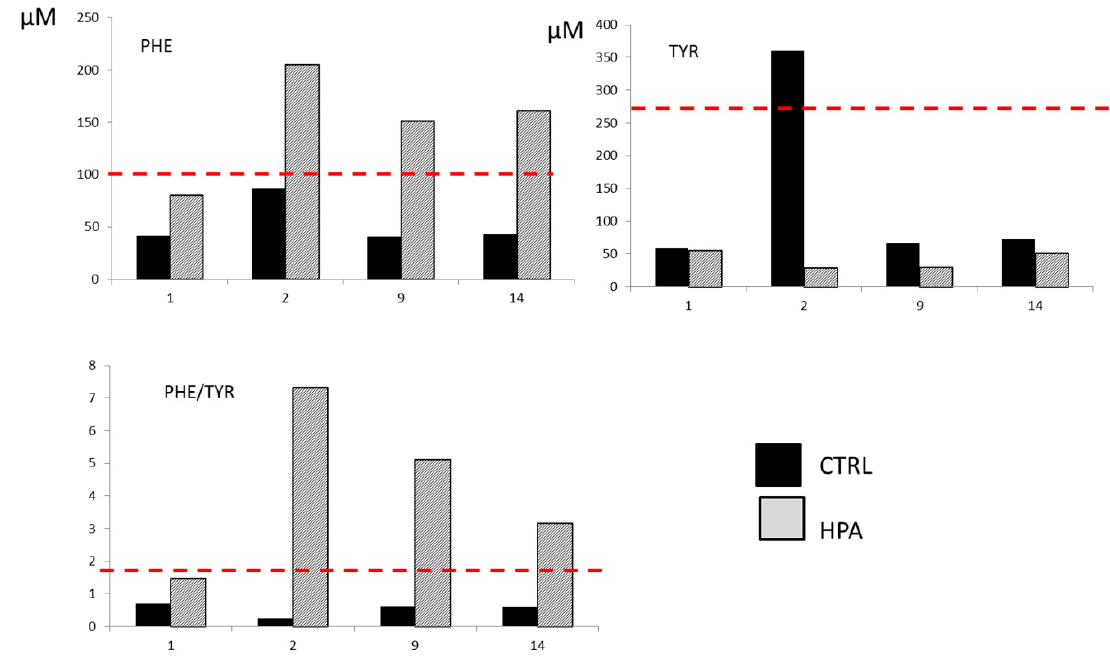
Figure 1. Alterations at expanded newborn screening (NBS). Histograms represent the levels of Phe, Tyr, and Phe/Tyr ratio at 1, 2, 9, and 14 days of life for HPA case (light ‐ gray bar) and for a healthy control newborn (black bar). Red dashed line indicates cut ‐ off limits for each analyte and for the ratio.